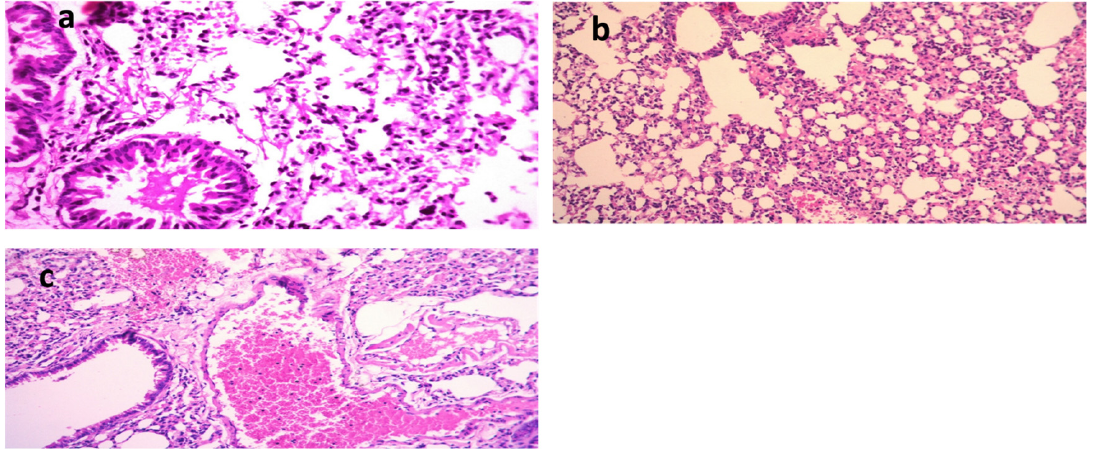
Figure 5. Histological sections of lungs stained with H&E and scoring of pulmonary lesions in a model of mice infected with MDR K. pneumoniae . ( a ) Mice infected with K. pneumoniae (X =400), ( b ) mice infected with K. pneumoniae and then treated with gentamycin (GEN) (X = 200), and ( c ) mice infected with K. pneumoniae and then treated with luteolin 4 ′‐ neohesperidoside (L4N) (X = 200). Table 5. Scoring of pulmonary lesions.